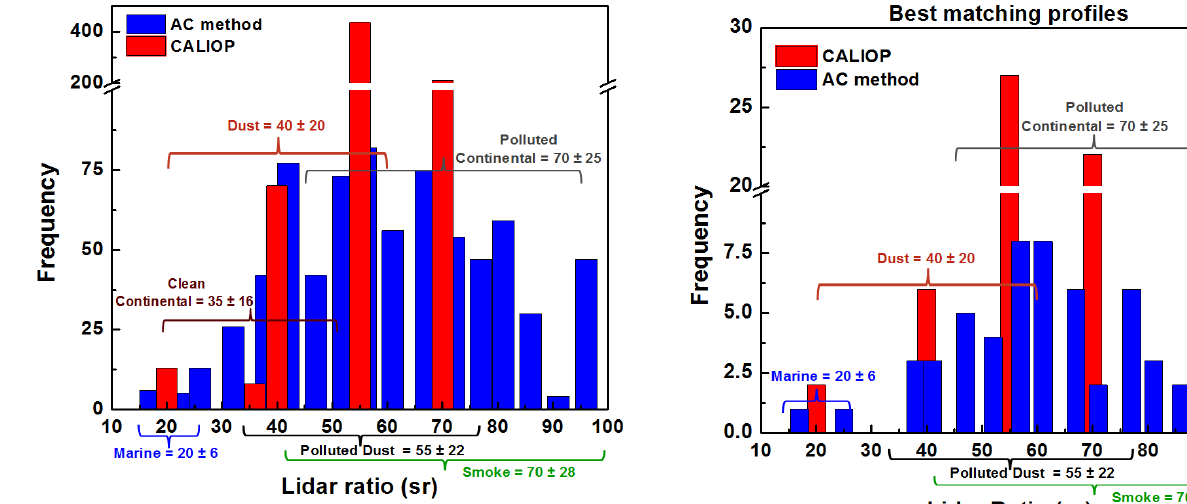
Fig. 6. Lidar ratio occurrence frequencies reported in the CALIPSO data products (red) and those derived using the AC model (blue) for the best matching profile. The natural variability ascribed to se- lected CALIOP aerosol models is shown by the ranges given along the lidar ratio axis. Lidar ratios derived by the AC model are seen to fall entirely within the range spanned by the CALIOP